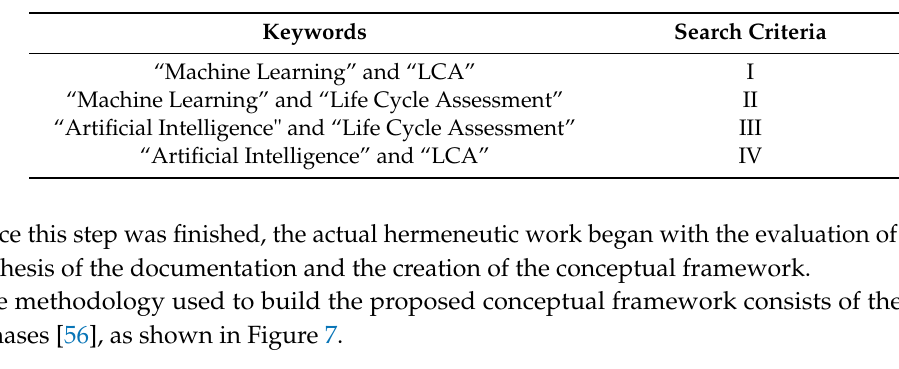
Table 1. Keywords used during systematic literature